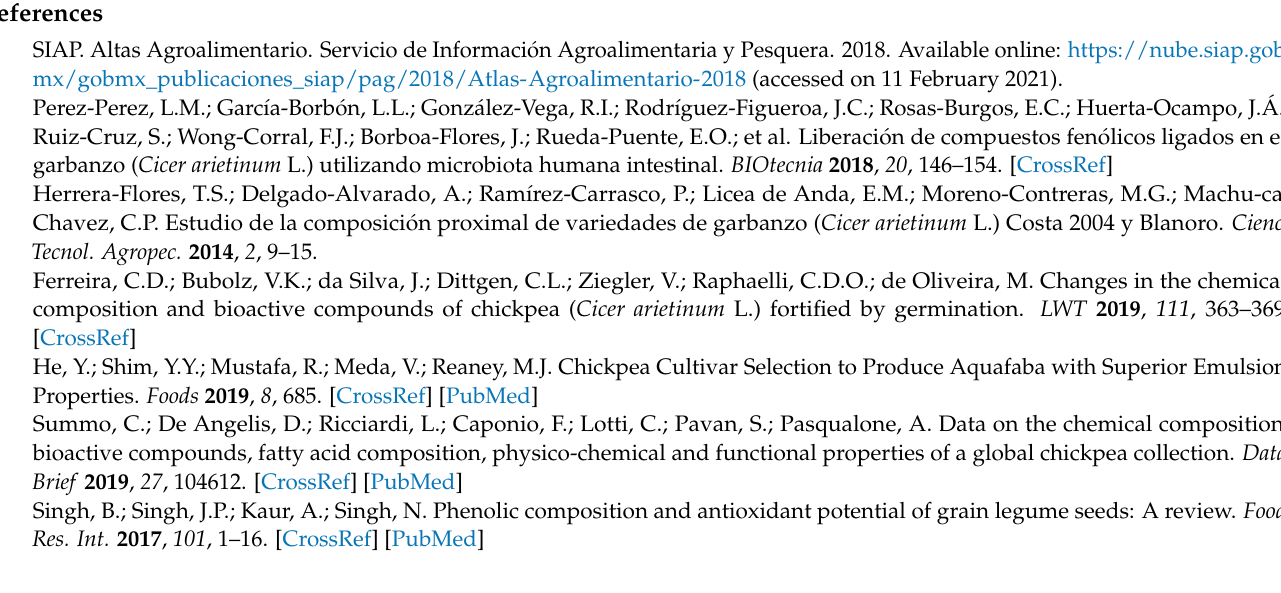
Figure S1: UPLC-MS chromatograms of the phenolic compounds identified in raw and cooked chickpea. Figure S2: UPLC-MS chromatograms of the phenolic compounds identified in the mouth. Figure S3: UPLC-MS chromatograms of the phenolic compounds identified in the stomach. Figure S4: UPLC-MS chromatograms of the phenolic compounds identified in the